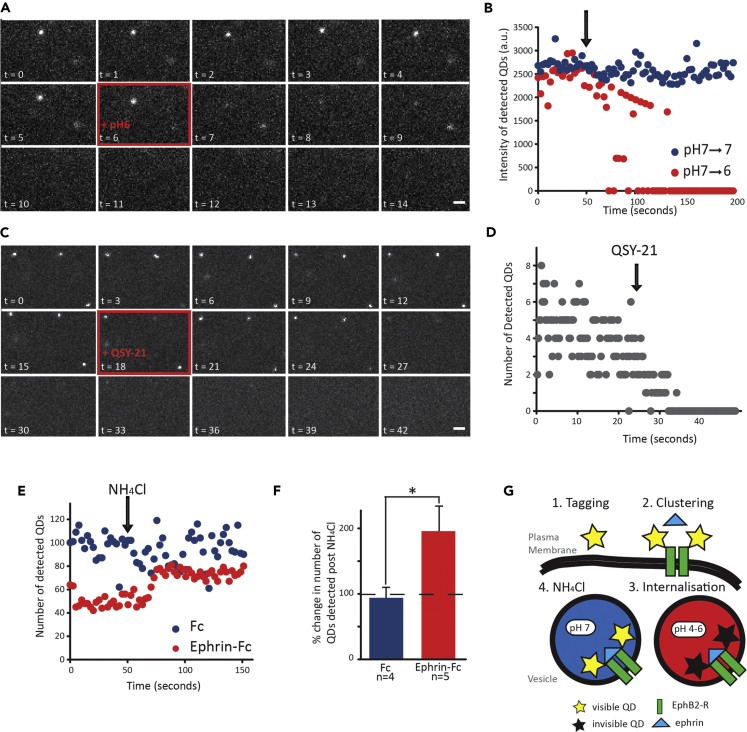
Single-Particle Tracking of EphB2Rs in Hippocampal Neurons with a Surface-Specific Quantum Dot Probe(A and B) (A) Example time-lapse image series (in seconds) and (B) mean fluorescence intensities of QD-EphB2Rs following addition of pH 6 solution (red box in A, red circles in B) compared with pH 7 control (blue circles, B); scale bars, 2 μm.(C and D) (C) Example time-lapse image series (in seconds) and (D) number of detected QD-EphB2Rs following addition of membrane-impermeable QSY-21 (100 μM) (red box in C).(E and F) Dissipation of intracellular pH gradients by application of NH4Cl (50 mM, pH 7.2) to neurons previously incubated with pre-clustered ephrinB1 (Ephrin-Fc; red circles, n = 5) or control Fc fragments (Fc; blue circles, n = 4) leads to a significant increase in detected QD-EphB2Rs in the former; (E) mean number of detected QD-EphB2Rs over time; and (F) quantification of change from baseline (p < 0.05, graph shows mean ± SEM).(G) Model illustrating experiments shown in (E and F): clustering of QD-labeled EphB2Rs leads to receptor internalization and hence QD fluorescence quenching. These QD-EphB2Rs are then revealed by neutralization of pH.